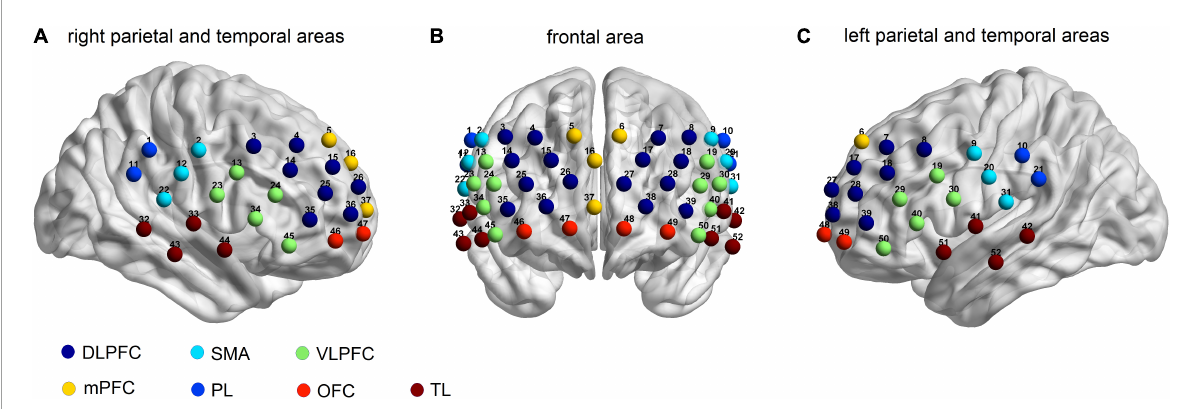
FIGURE1 Locations of the 52-channels for the functional near-infrared spectroscopy (fNIRS). Estimated cortical areas corresponding to each channel using the virtual registration method in (A) the right parietal and temporal areas, (B) the frontal area, and (C) the left parietal and the temporal